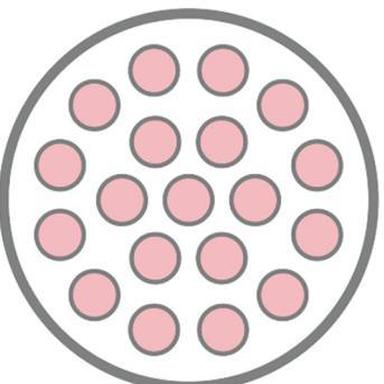
Schematic arrangement of fuel pins in natural uranium cluster.